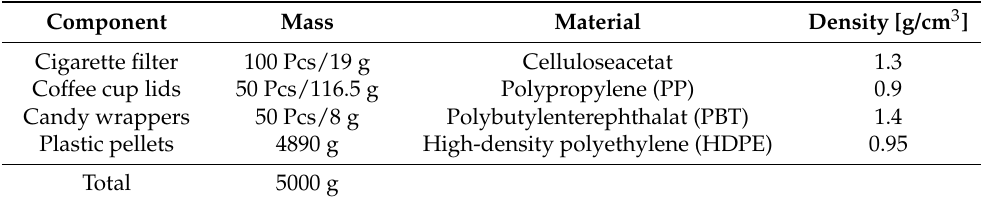
Table 7. Defined test substance/littering.